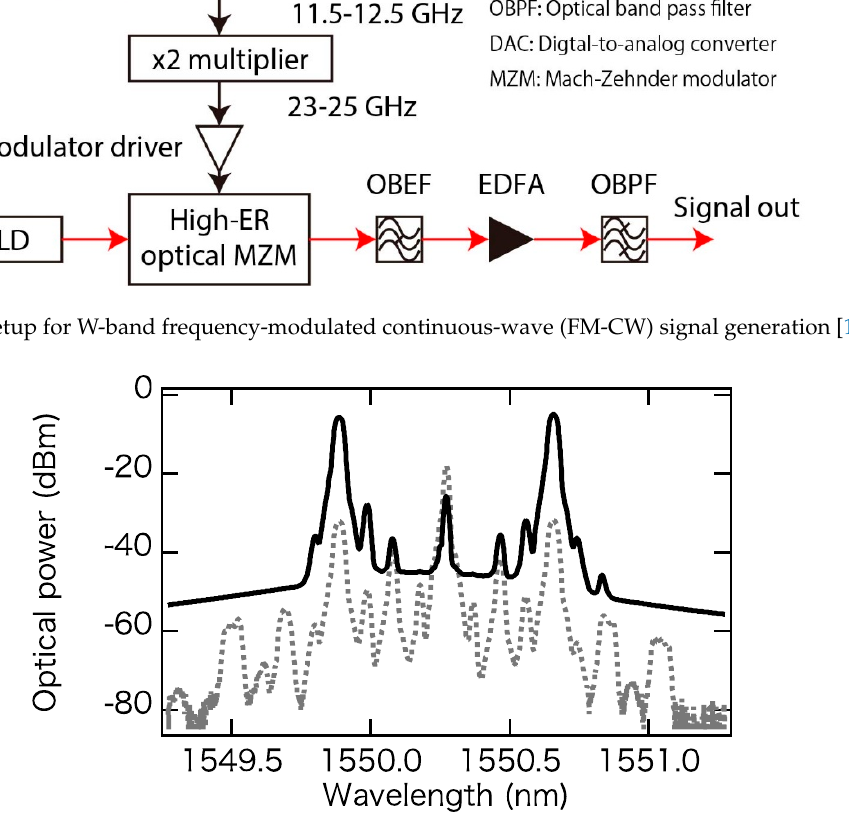
Figure 6. Optical spectra of optical FM-CW signals consisting of the upper and lower sidebands of the Mach–Zehnder modulator (MZM) output (gray thin line) and at the optical band pass filter (OBPF) output (black solid line) [12].